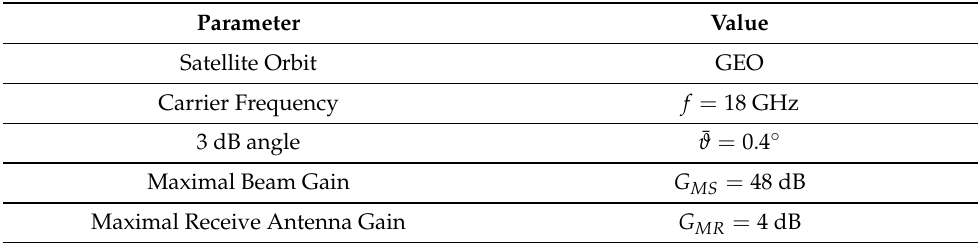
Table 2. System parameters.